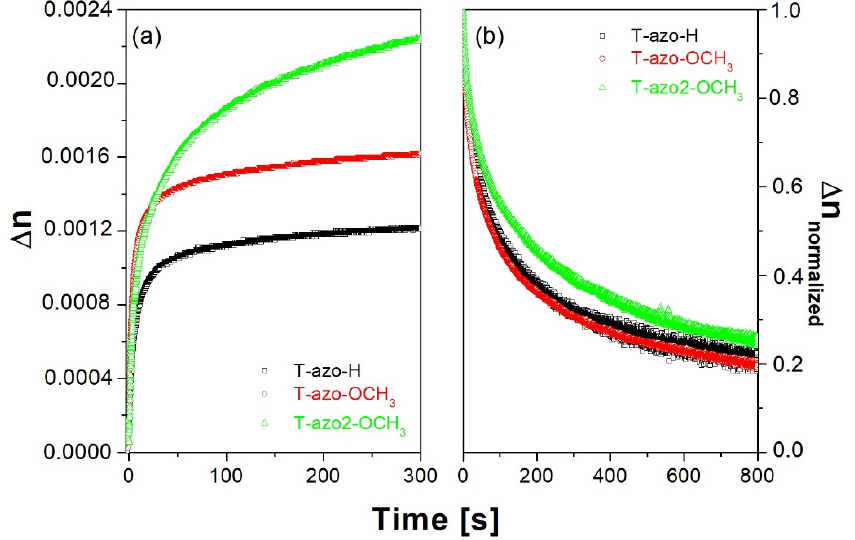
Figure 5. Birefringence ( a ) growth and ( b ) normalized relaxation curves for the thiazole–azo dyes